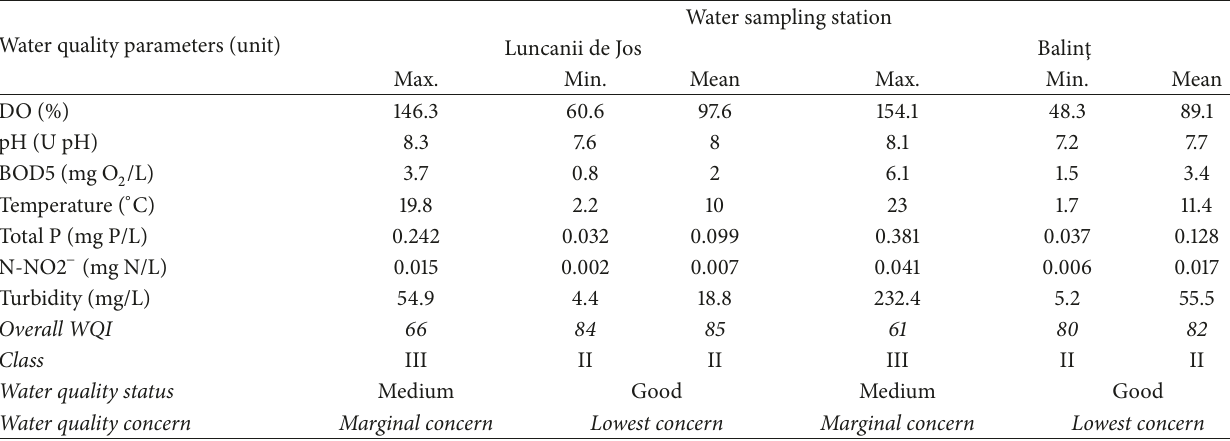
Table 4: Water quality status and WQI values at sampling stations from the Bega River.